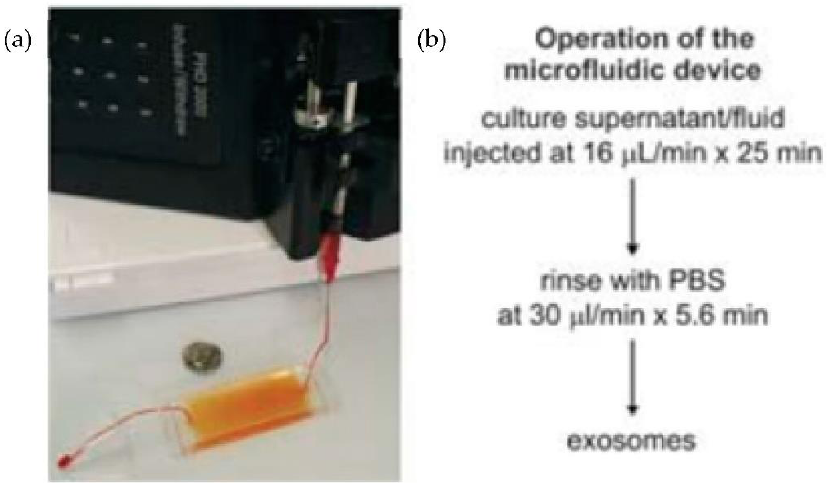
Figure 7. Experimental setup of microfluidic devices. ( a ) Photo of the device with a syringe pump. ( b ) Procedure for the isolation of microvesicles from the microfluidic device. (Reproduced from Chen et al. [31]. Copyright 2010, Lab Chip.).